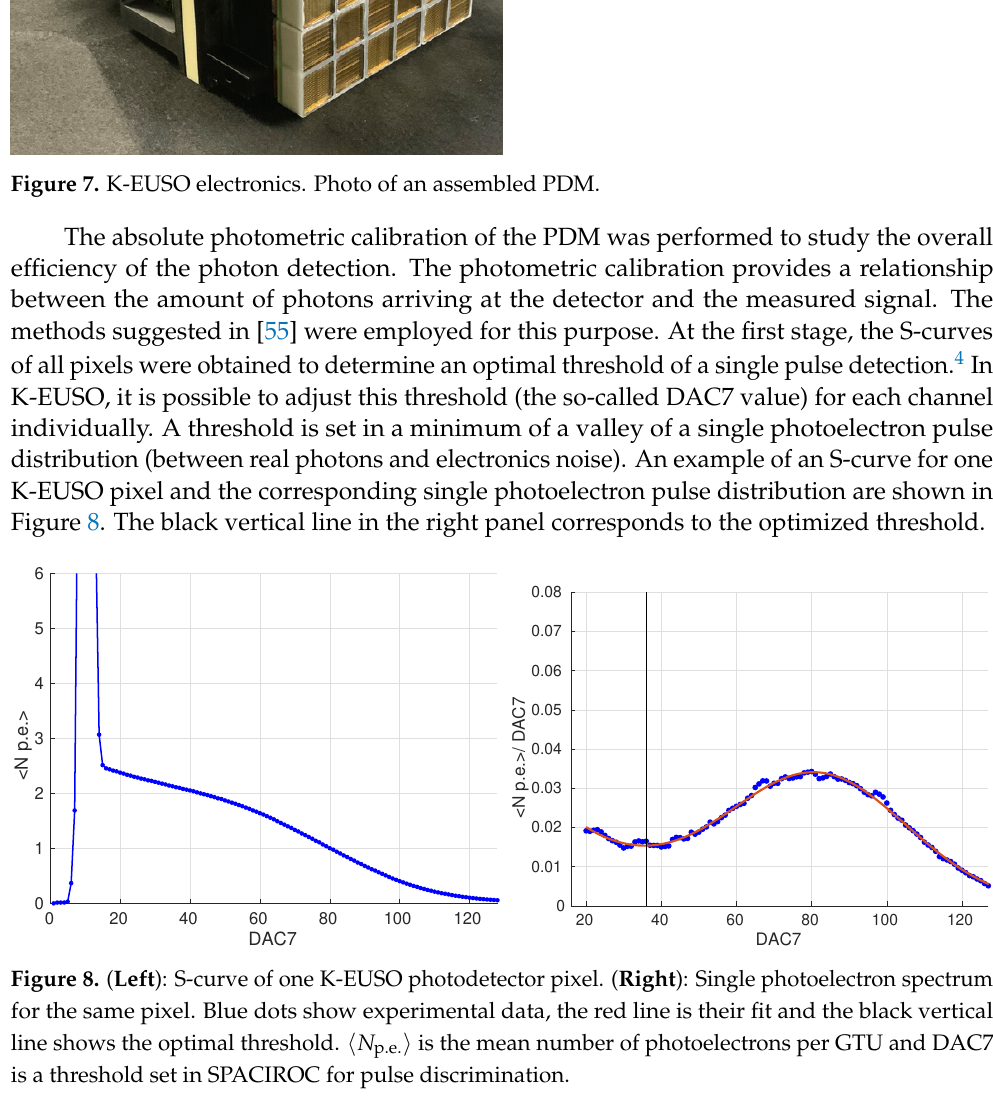
Figure 8. ( Left ): S-curve of one K-EUSO photodetector pixel. ( Right ): Single photoelectron spectrum for the same pixel. Blue dots show experimental data, the red line is their fit and the black vertical line shows the optimal threshold. (cid:104) N p.e. (cid:105) is the mean number of photoelectrons per GTU and DAC7 is a threshold set in SPACIROC for pulse